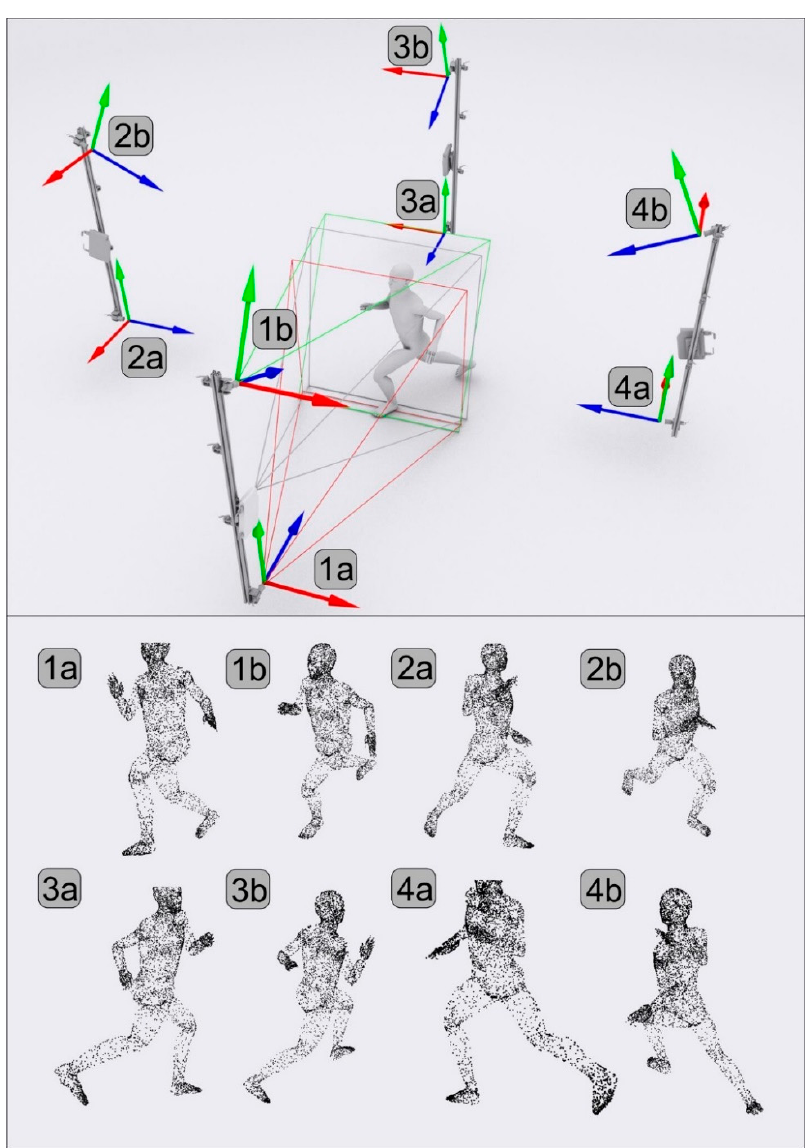
Figure 11. Integration of the four DMH coordinate systems using the camera coordinate systems depicted in 1a–4b and respective point clouds. Note that the number of points was reduced to improve the clarity of the figure.